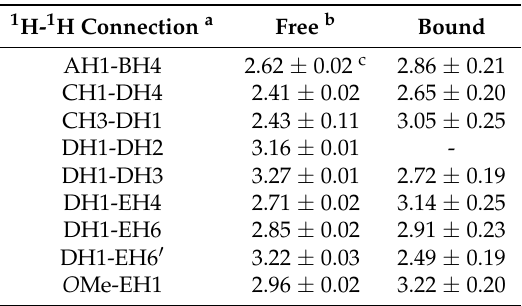
Table 2. Nuclear Overhauser effect (NOE)- and trNOE-derived interproton distances of Fx free and bound to LAR-Ig1-2. Adapted with permission from Gao et al. Biochemistry 2018, 57, 2189–2199. Copyright. 2018 American Chemical Society